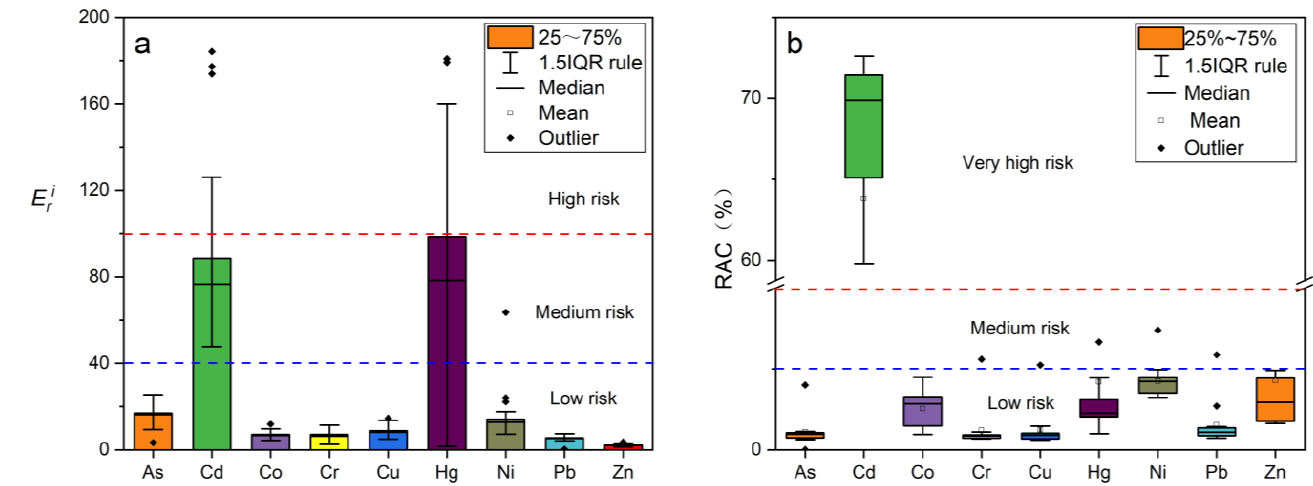
Figure 6. E i r ( a ) and RAC ( b ) values of heavy metals in the 35 surface soils from Hetao Plain in Bayannur.